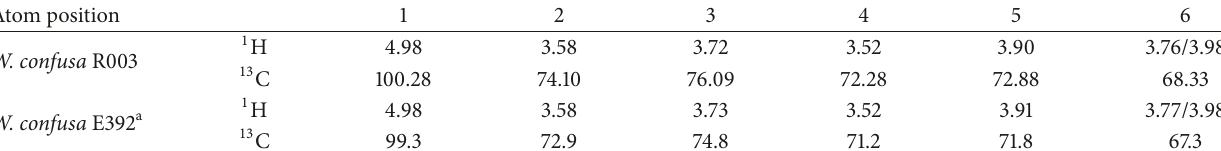
Table 1: Assignment of 1 H/ 13 C chemical shift of dextran from W. confusa R003 correlated with dextran from W. confusa E392.